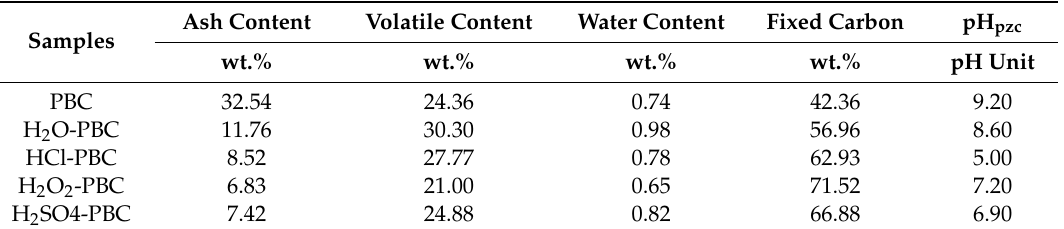
Table 1. Physiochemical properties of the original and acid-modified biochar.